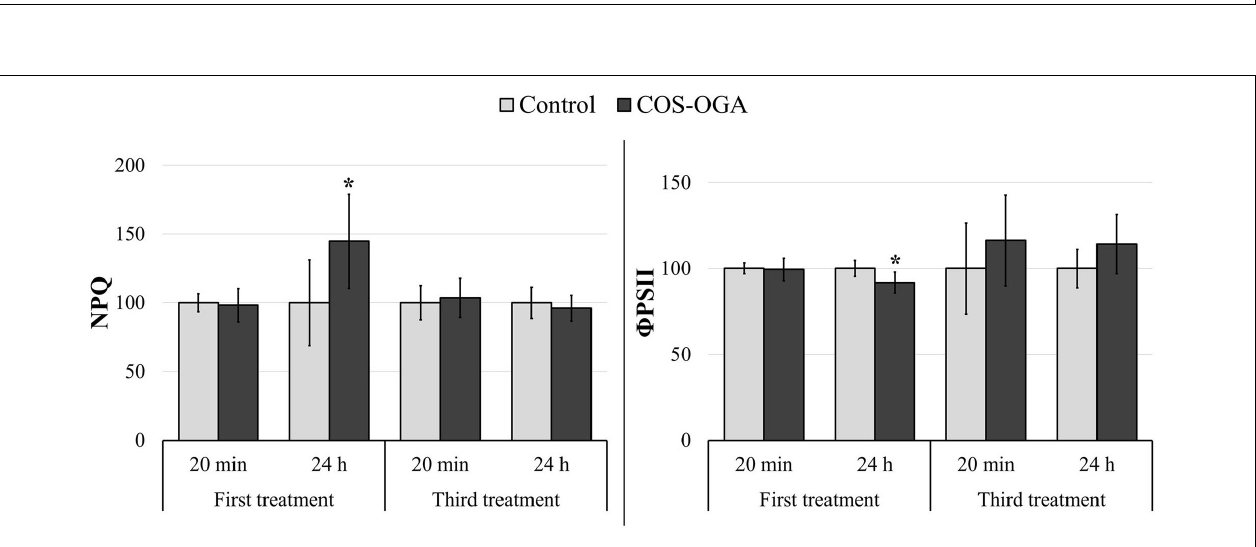
FIGURE 3 | Chlorophyll fluorescence parameters of tomato plants 20 min and 24 h after the first and the third sprayings with chitooligosaccharides–oligogalacturonides (COS-OGA; 62.5 mg/l). PSII operating efficiency ( (cid:56) PSII) and non-photochemical quenching (NPQ) were calculated from fluorescence kinetic data generated during the quenching protocol (Fluorcam). These parameters were determined after 20 min dark adaptation. The average values of fluorescence parameters are expressed as a percentage of the control ± standard deviation ( n = 6). *indicates a statistically significant difference to control with p < 0.05 (Student’s t test, R